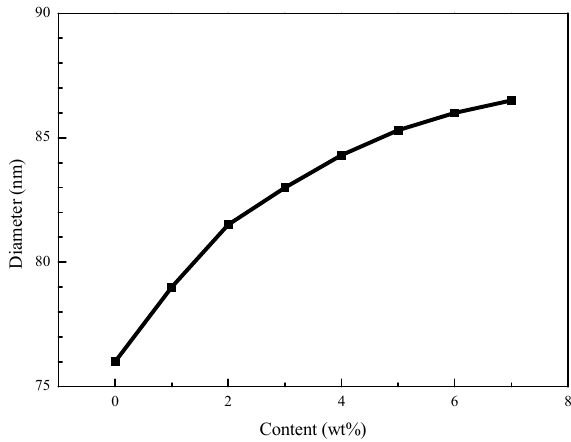
Figure 4. Effects of dodecafluoroheptyl methacrylate (DFMA) dosages on Si/F polyacrylate latex particle size.